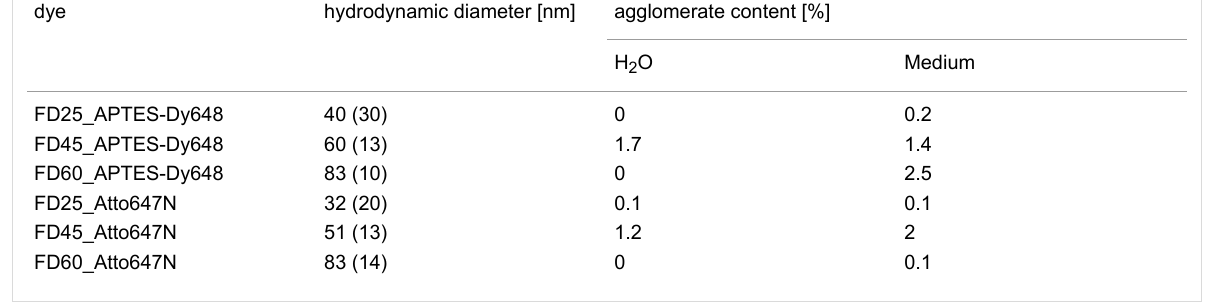
Table 5: Stability of Atto647N- and Dy-648-modified silica particles measured and calculated by dynamic light scattering. Particles were either diluted (1:100 v/v) with ultrapure H 2 O or MEM/FBS (20%) medium and incubated for 24 h before the mass-weighted agglomerate content was calculated. Numbers in brackets represent the size dispersity in percent.